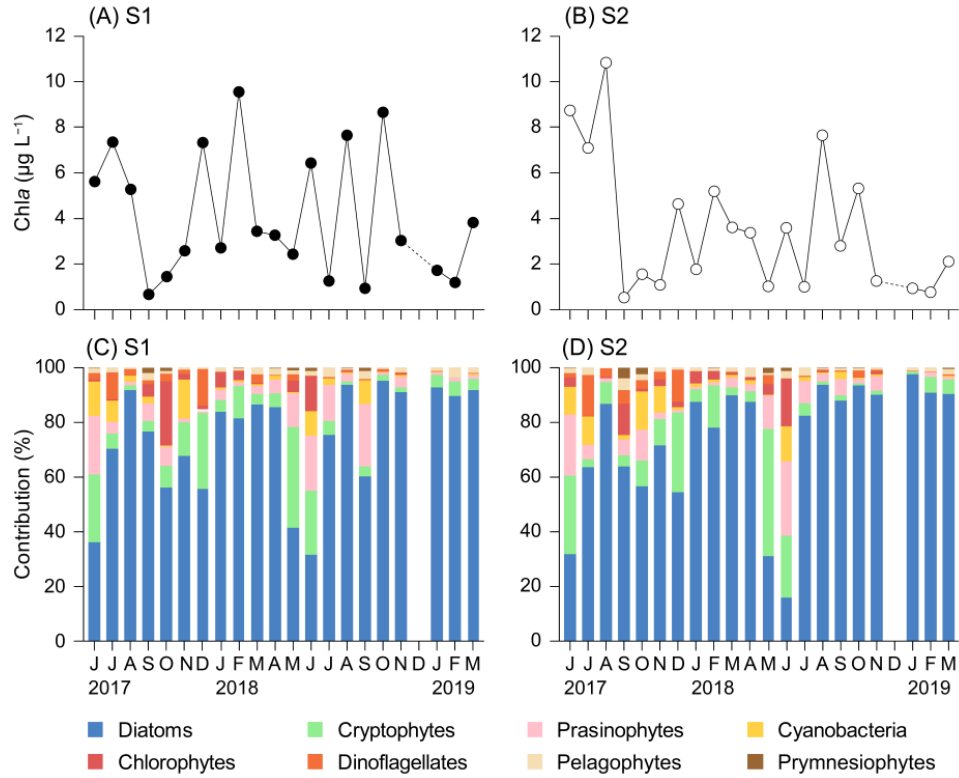
Figure 3. ( A , B ) Seasonal variations in the total chlorophyll a (Chl a ) concentration and ( C , D ) relative contributions of different phytoplankton groups to total Chl a at the sampling sites.